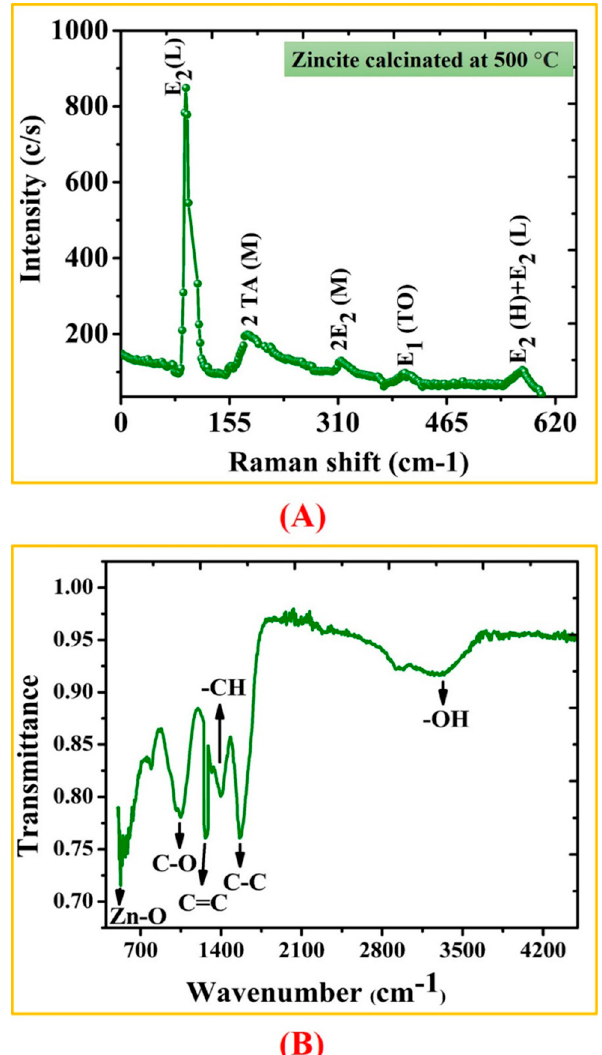
Figure 3. ( A ) Raman spectra of the ZnONPs biosynthesized using zinc nitrate hexahydrate as precursor ( B ) FTIR spectra of ZnONPs.